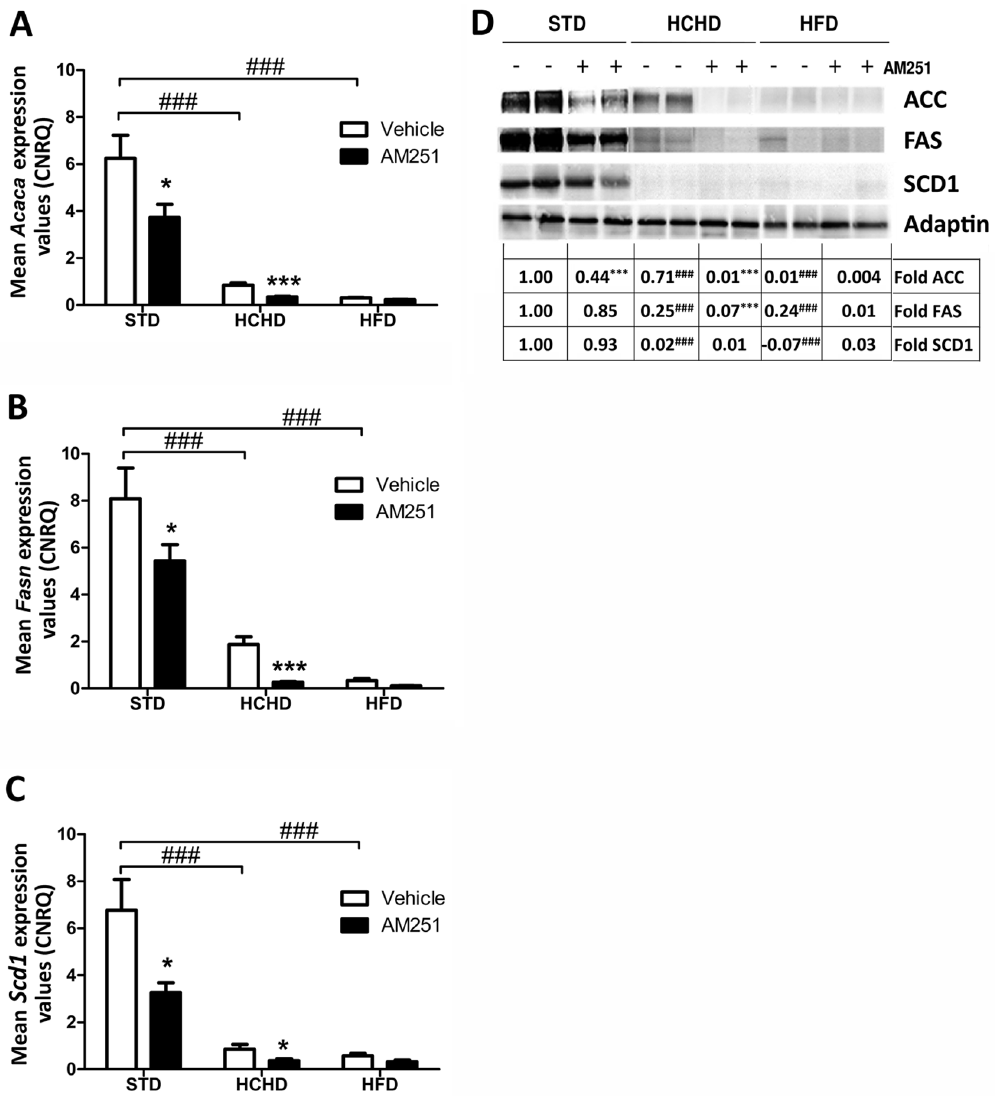
Figure 5. Effect of obesogenic diets and AM251 on the lipogenic enzyme gene and protein levels in PrAT. The gene expression of Acaca ( A ), Fasn ( B ) and Scd1 ( C ) was determined after qPCR analysis in PrAT of STD, HCHD or HFD-fed animals vehicle-treated or AM251-treated (3 mg/kg, daily, i.p.). Columns are means 6 SEM (n=6 animals per group). Western blot analysis of protein content of ACC, FAS and SCD1 was determined in PrAT extracts ( D ). Two samples of each group are shown as representative. Relative ACC, FAS and SCD1 protein levels were determined by densitometry corrected for Actin. Protein levels are expressed as the fold over the STD-vehicle treated group (set as 1) for each protein as indicated at the bottom of the respective blot. Differences between diets were analyzed by one-way ANOVA and Bonferroni’s post-hoc test, and comparisons between groups treated with AM251 or vehicle were analyzed by Student’s t test. ### p , 0.001 denotes significant differences compared with the STD-fed group treated with vehicle. * p , 0.05 and *** p , 0.001 denote significant differences compared with the corresponding vehicle-treated group.